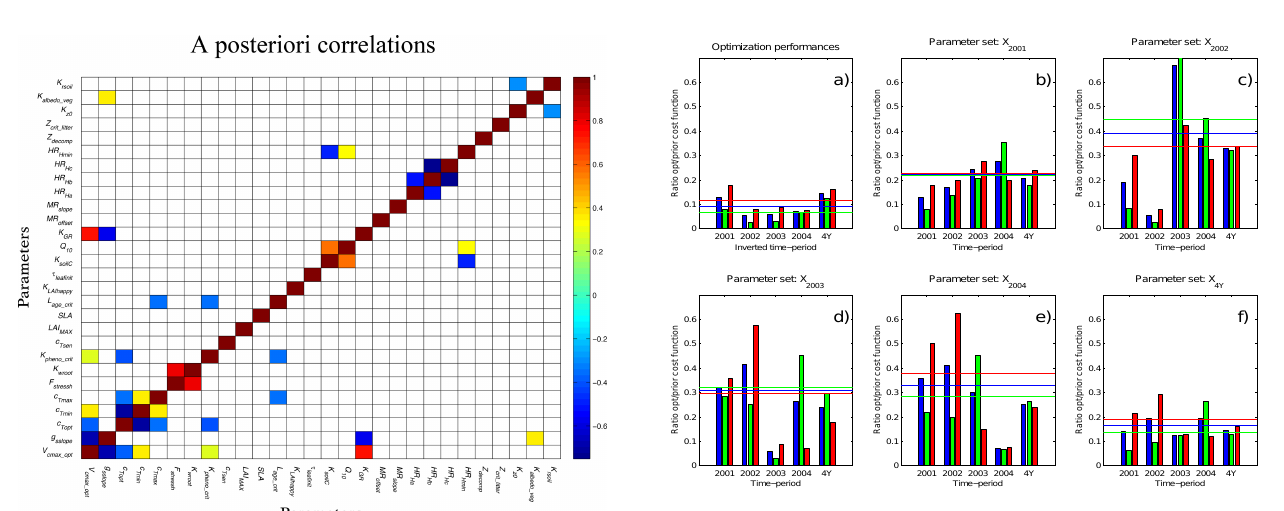
Figure 4. (a) Cost function reductions after optimization of the model against observations of each time period (2001, 2002, ..., 4 Y for the whole 2001–2004 time period). Blue bars are associated with the term of the cost function representing the total data–model misfit ( J OBS , Eq. (1)); green and red bars are associated with partial cost functions relative to NEE and LE data, respectively ( J NEE and J LE ). The horizontal lines represent the mean values of the corre- sponding cost functions reductions. Figures (b) , (c) , ..., (f) show the cost function reductions produced when running the model with the corresponding optimized parameter sets ( X 2001 , ..., X 4 Y ) in every time period. Horizontal lines are the averaged cost function reductions across other years than the one used to optimize the